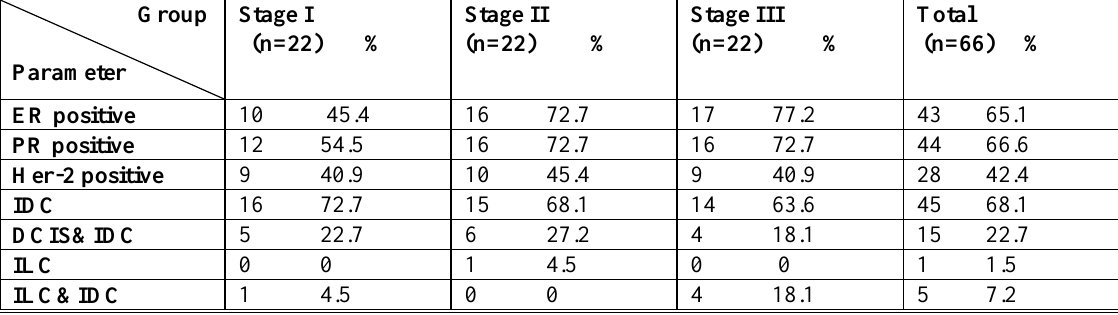
Table4. Basic criteria of studied patients in different stages of breast cancer Group